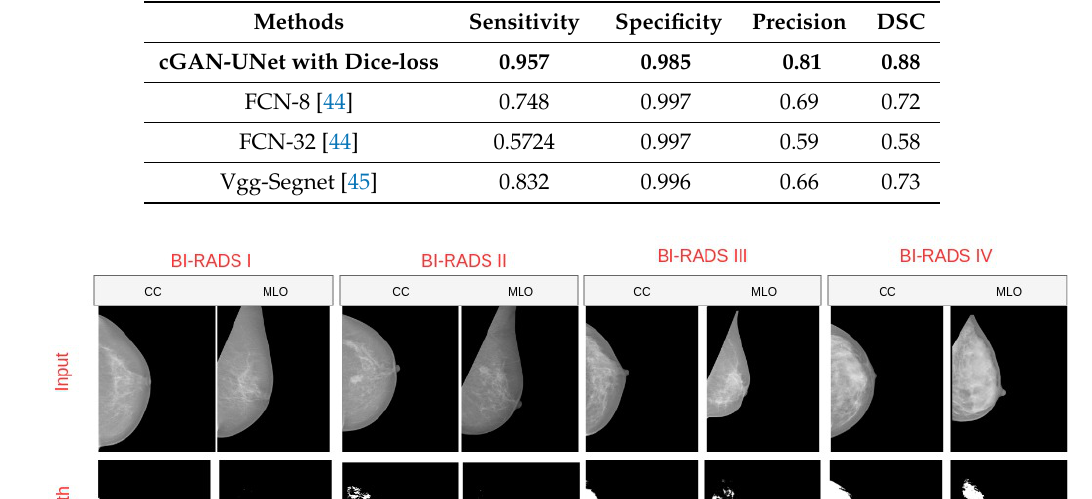
Summary of Sensitivity, Specificity, FPR, FNR, Precision, and DSC with the cGAN-UNet-MSE-loss, FCN8, FCN32, and VGG-SegNet methods evaluated on the testing set of the INBreast dataset for breast density segmentation.